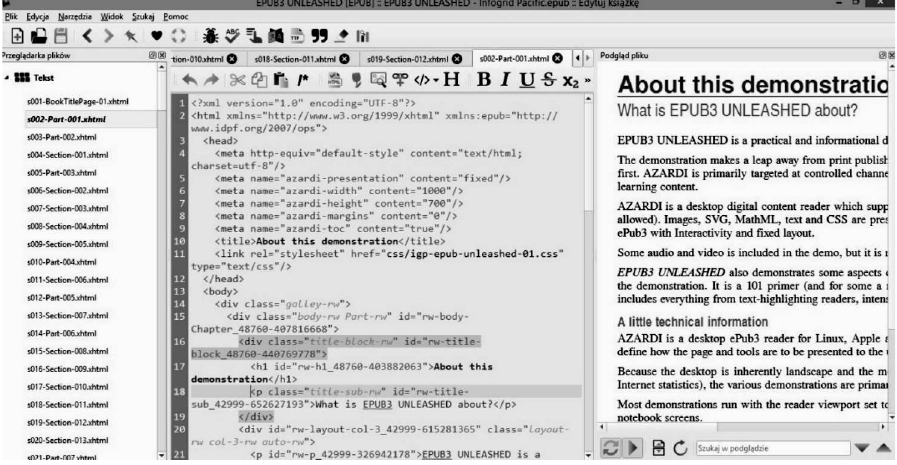
Figure 5. Calibre’s edit